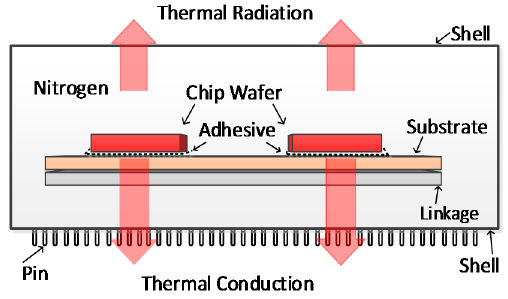
Figure 7. Equivalent heat structure chart for the SiP.